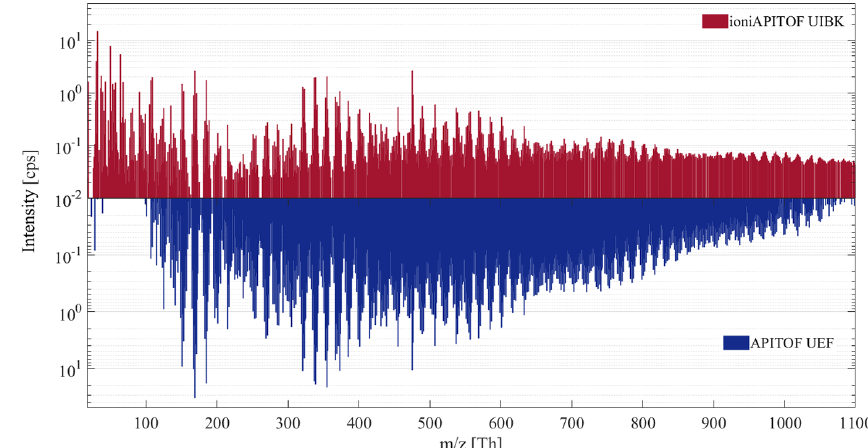
Figure 9. Comparison of the mass spectra obtained during run 1963.15 at the CLOUD experiment at CERN of the ioniAPi-TOF and the UEF APi-TOF. Table 5. Experimental conditions for the inter-comparison during run 1963.15 at the CLOUD experiment, CERN. Run number Temperature Rel. humidity Ions NH 3 SO 2